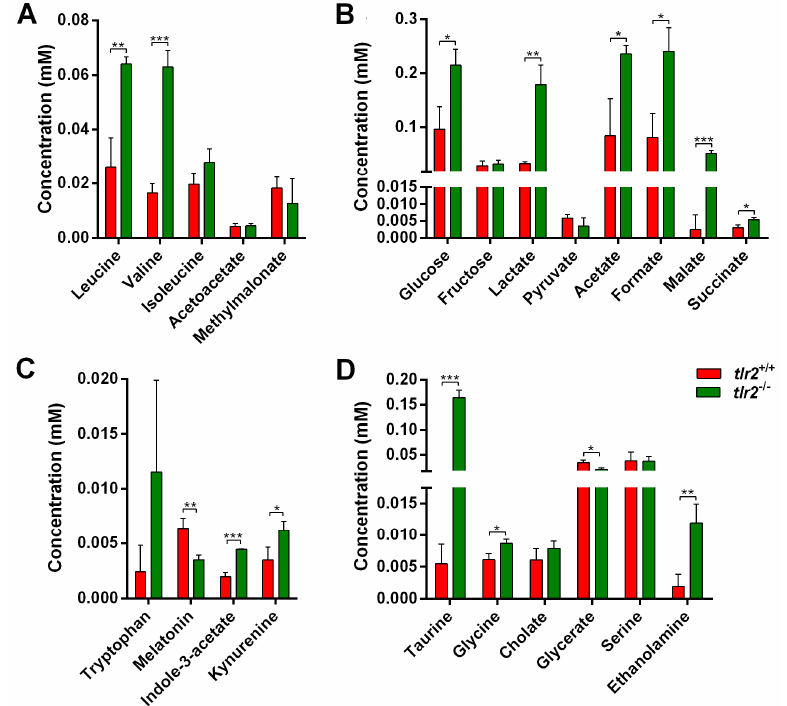
Figure 5. Quantitation of metabolites belonging to four significantly enriched metabolism-related pathways in tlr2 mutant zebrafish larvae. ( A ) The concentration of the metabolites in the valine, leucine, and isoleucine degradation pathway. ( B ) The concentration of the metabolites in the glycolysis and gluconeogenesis pathway. ( C ) The concentration of the metabolites in the tryptophan metabolism pathway. ( D ) The concentration of the metabolites in the fatty acid metabolism pathway. N = 3; * represents p < 0.05; ** represents p < 0.01; *** represents p < 0.001. 3.4. Glucose Levels and Transcription of Glycolytic Enzymes in tlr2 Mutant Zebrafish To corroborate the increase in glucose content in tlr2 mutant zebrafish larvae, an assay using a glucose fluorometric kit was performed. The results showed that glucose content was significantly higher in the tlr2 mutant than in the wild type larvae, which is consistent with the results obtained by NMR analysis (Figure 6A,B).